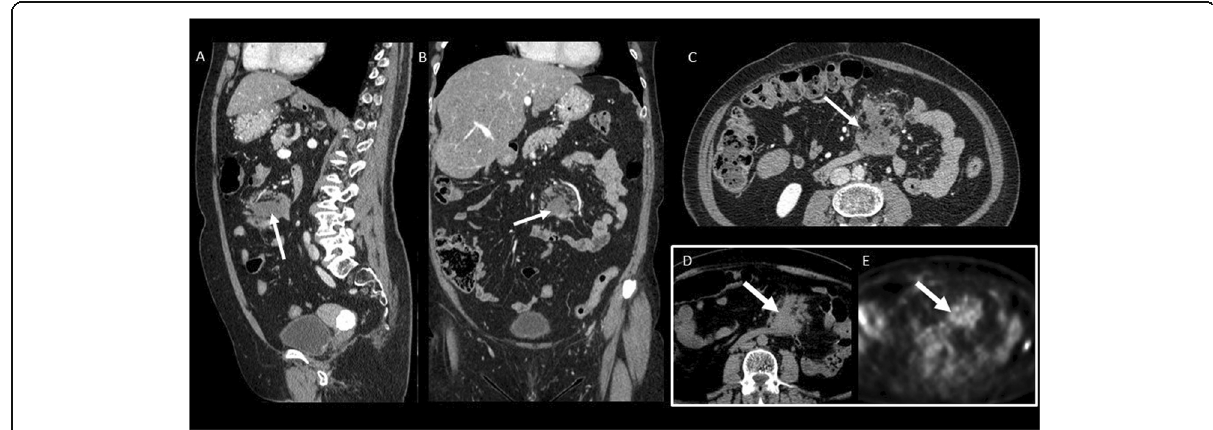
Fig. 8 Asymptomatic patient performed a CT in order to stage a bladder cancer. Contrast-enhanced CT images (( a ) sagittal, ( b ) coronal, and ( c ) axial planes) incidentally visualized ill-defined mass in the mesentery characterized by a mild contrast enhancement (white arrow). At CT-PET examination, the mass shows a mild to moderate